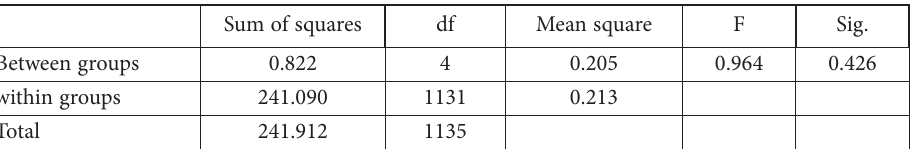
Table 5. Results of one-way analysis of variance test to determine the difference practicing creative thinking among Jordan University of Science and Technology students due to academic year (source: created by authors) Sum of squares df Mean square F Sig. Between groups 0.822 4 0.205 0.964 0.426 within groups 241.090 1131 0.213 Total 241.912